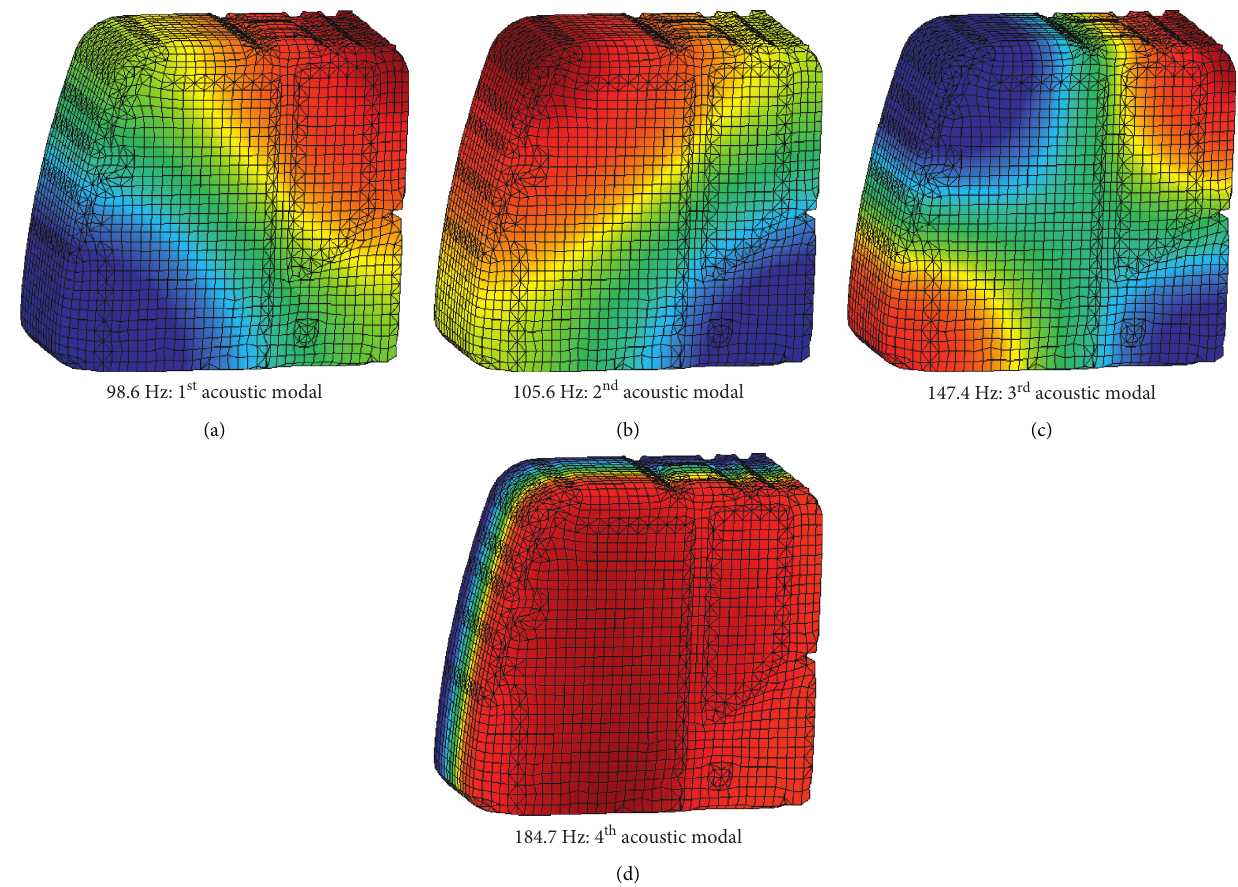
Figure 4: The acoustic modal of the cab. (a) 98.6Hz: 1 st acoustic modal. (b) 105.6Hz: 2 nd acoustic modal. (c) 147.4Hz: 3 rd acoustic modal. (d) 184.7Hz: 4 th acoustic modal.